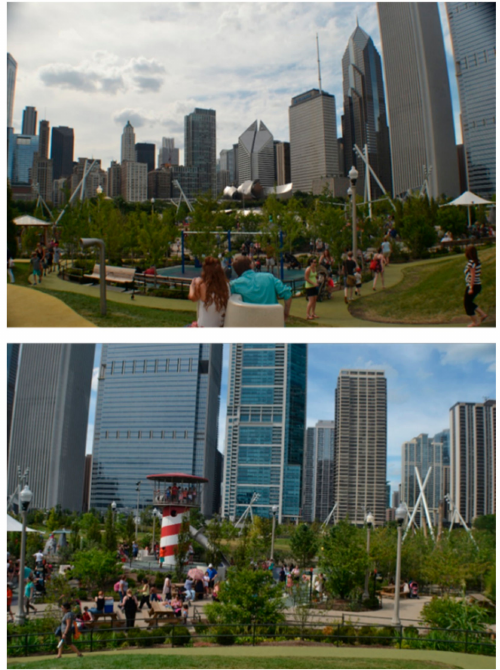
Figure 7. Maggie Daley Park. Study participants appreciated the 20-acre park for providing spaces and activities that cater to all ages to enjoy, relax, and play in. They also appreciated the park’s hills, valleys, and vistas that animate the place and shield visitors from the sun, wind, and tra ffi c noise. Further, the park’s curvilinear and intricate topography o ff ers a complimenting contrast to the city’s flat and gridded character. In addition, its relentlessly heterogeneous space complements that of Grant Park’s formal